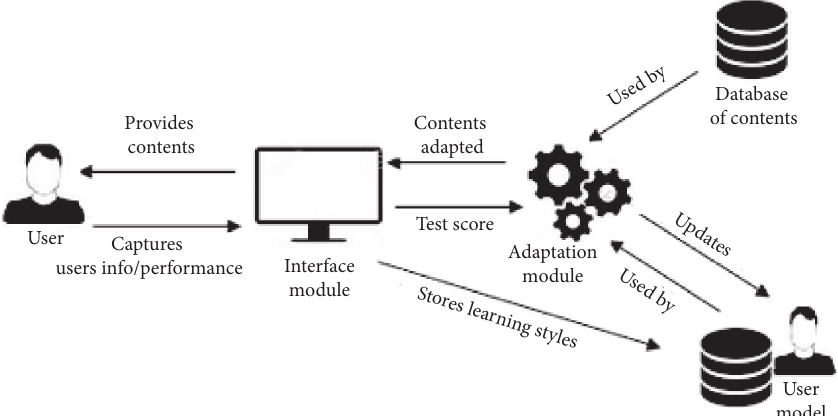
Figure 3: Architecture of